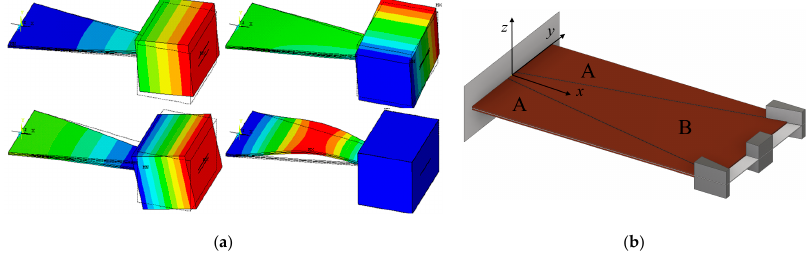
Figure 8. PEH geometry variations: optimized shape bimorphs proposed in [76]-reprinted by permission from Springer Nature ( a ) and segmented PEH geometry proposed in [32] ( b ).